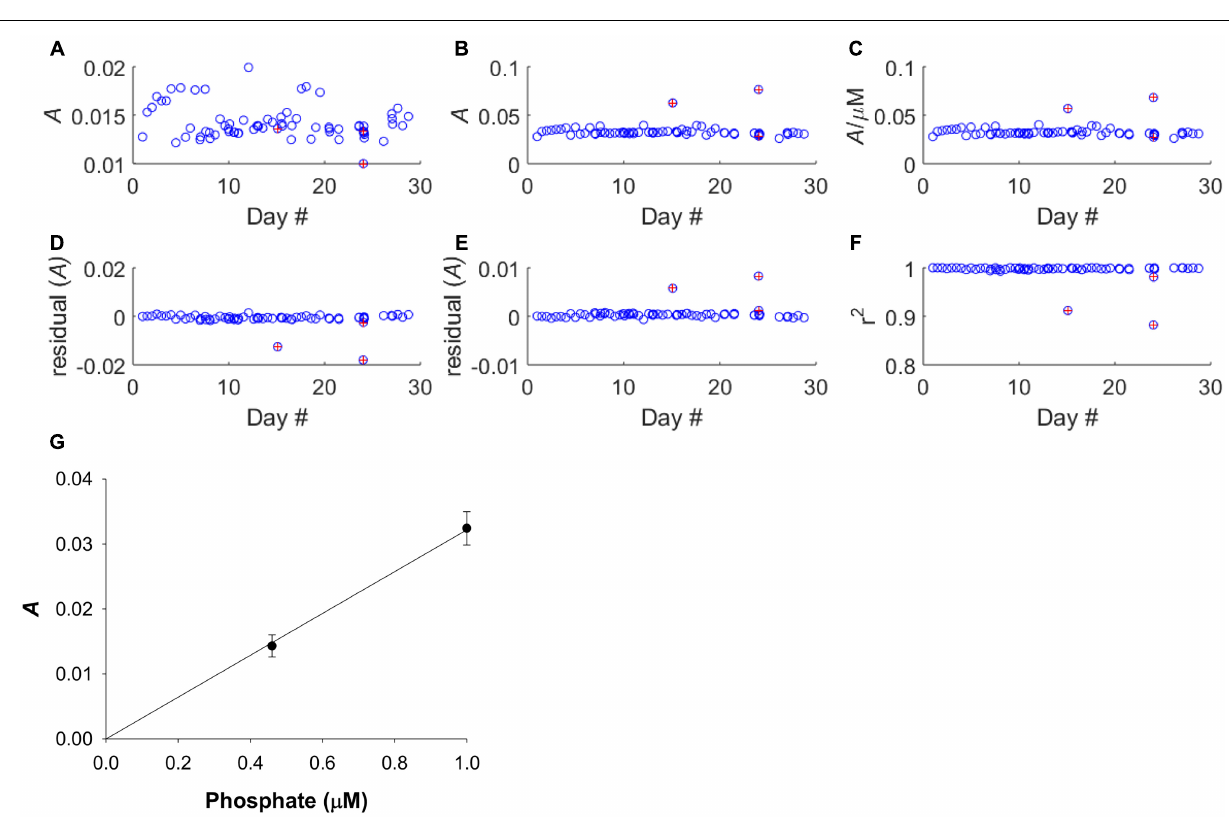
Frontiers in Marine Science |